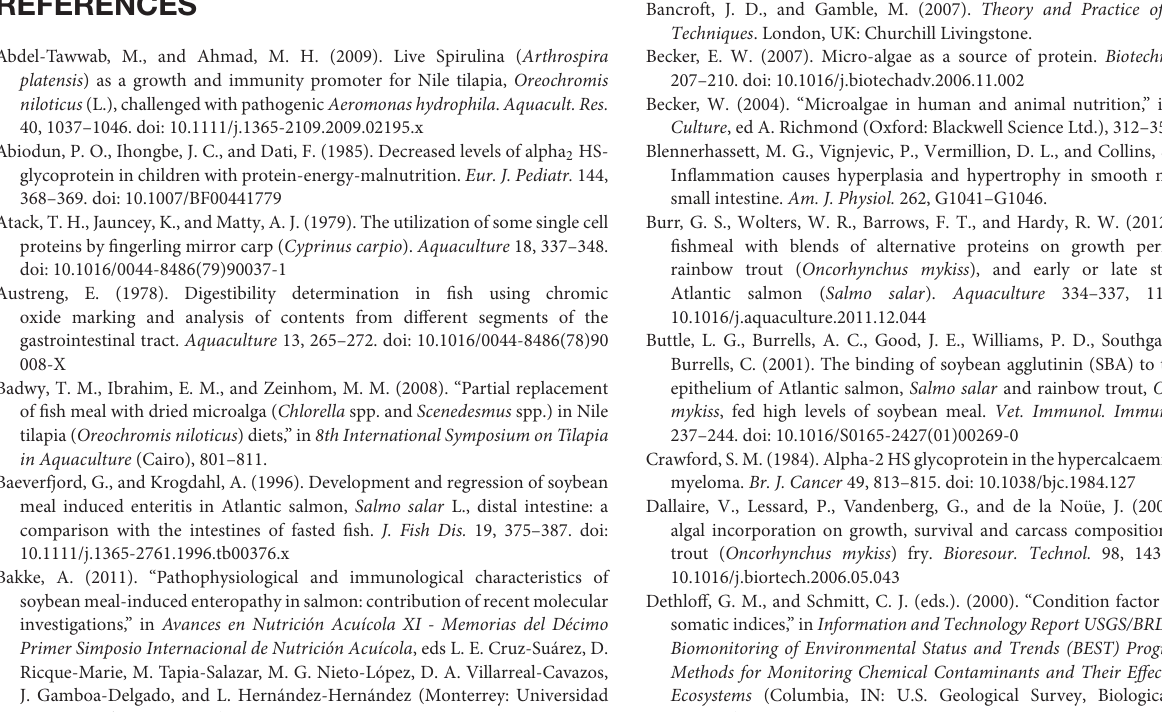
Supplementary Figure 1 | Photomicrographs of the distal intestine of Atlantic salmon from the different study groups. Scale bar: 50 µ m. Supplementary Figure 2 | 2-DE gels and the volumes of the differentially expressed protein spots. ∗ Different letters above the bar graphs indicate statistically significant differences. Values are presented as mean ±